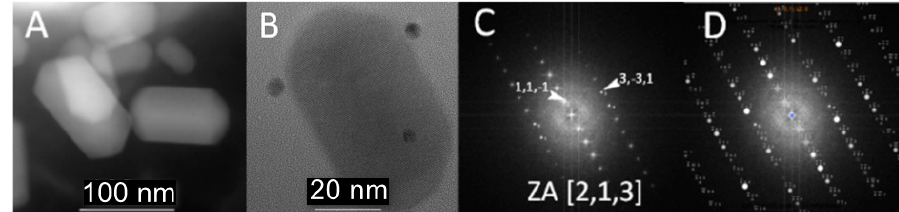
Figure 2. Structure and analysis of the specimen. ( A ) Random arrangement of crystals with an acicular prismatic morphology. ( B ) High-resolution imaging: the dark dots are gold nanoparticles used as fiducial markers for tomography. ( C ) FFT micrograph of the image in ( B ): the zone axis of the crystal is parallel to the <111> crystallographic direction. ( D ) Simulated diffraction pattern.